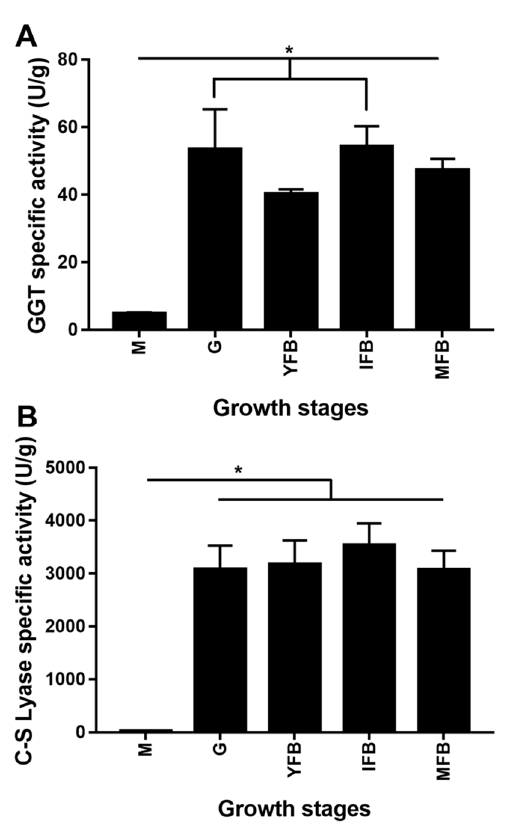
Figure 4. ( A ) The specific activity of GGT at the five growth stages. The reaction mixture containing the enzyme and the GPNA substrate was analyzed under standard conditions, and the residual activity was calculated. ( B ) The specific activity of C-S lyase at the five growth stages. The reaction mixture containing the enzyme and S-ethyl-L-cysteine sulfoxide substrate was analyzed under standard conditions, and the residual activity was calculated. M, mycelia; G, grey; YFB, young fruiting body; IFB, immature fruiting body; MFB, mature fruiting body. Error bars indicate standard deviation for three independent experiments. * p < 0.05, ANOVA tests by Duncan’s indicate significant